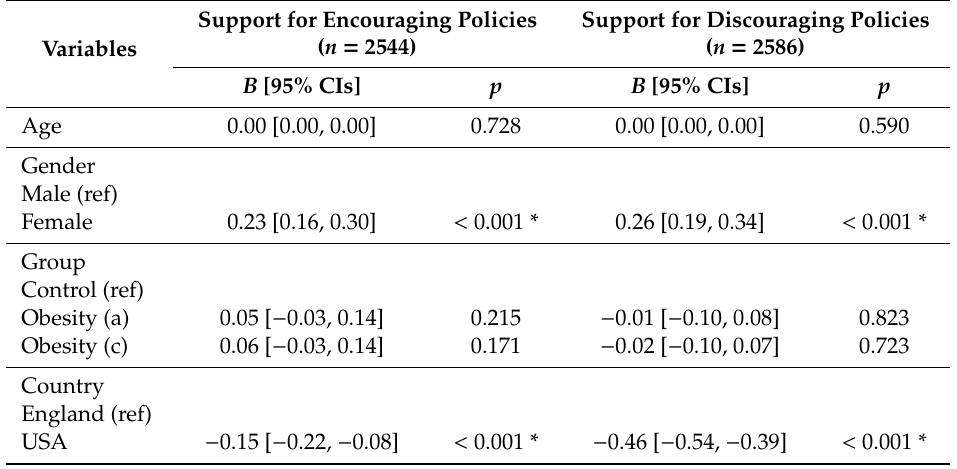
Table 3. Main e ff ects of intervention messages on support for obesity prevention policies (Study 2).